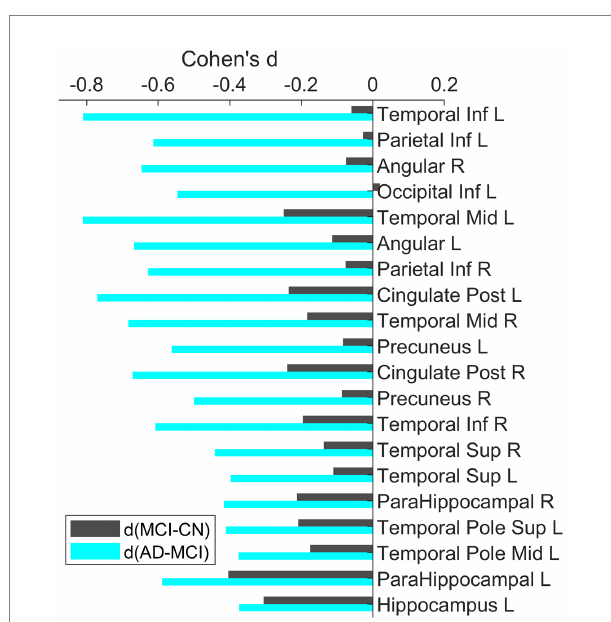
FIGURE 3 Bar plots of the effect sizes for the contrast MCI-CN and AD-MCI using baseline FDG-PET data. All these ROIs were identified to have significant group differences. The ROIs were sorted based on the difference of the effect sizes for the two contrasts. Across all these ROIs, the group differences between AD and MCI had larger effect than the differences between MCI and